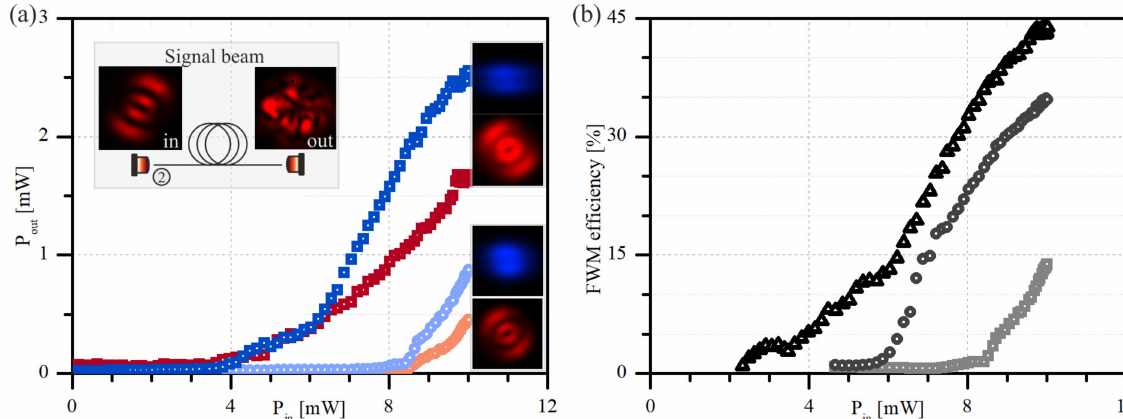
Figure 5. The experimental results of the FWM process realized in 0.8 m FMF fiber in the presence of a co-propagated signal beam: ( a ) output power of the Stokes (light red circles) and anti-Stokes (light blue circles) beams plotted as a function of the power of the pump beam for propagation without signal beam and together with a signal beam of a power of 40 µ W (dark red and dark blue squares, respectively). The insets in ( a ) present the modal field distribution of a signal beam at the input and output of the fiber for signal beam propagation only (left panel), and Stokes/anti-Stokes modal field profiles obtained in the FWM process realized with and without signal beam of a 40 µ W optical power (bottom and top right panels, respectively); ( b ) FWM wavelength conversion efficiency plotted as a function of the power of the pump beam (532 nm), for the signal beam powers equal 0 µ W, 12 µ W and 40 µ W (light grey squares, grey circles and black triangles,